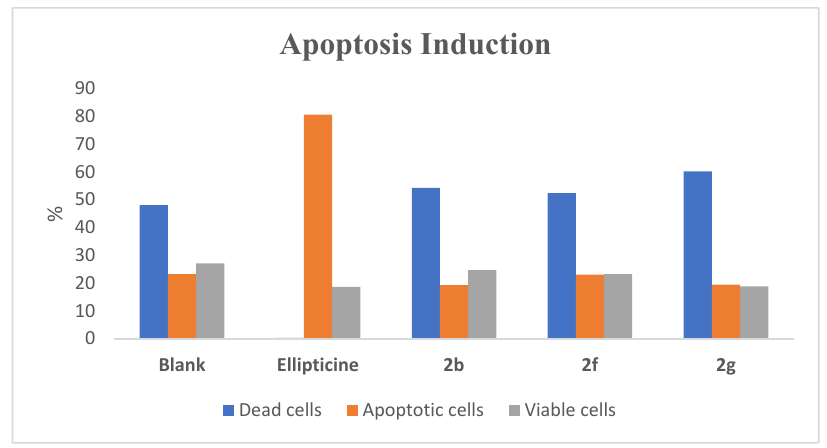
Figure 3. Induction of apoptotic process by compounds 2b , 2f , and 2g at their GI 50 values in AGS cell line.